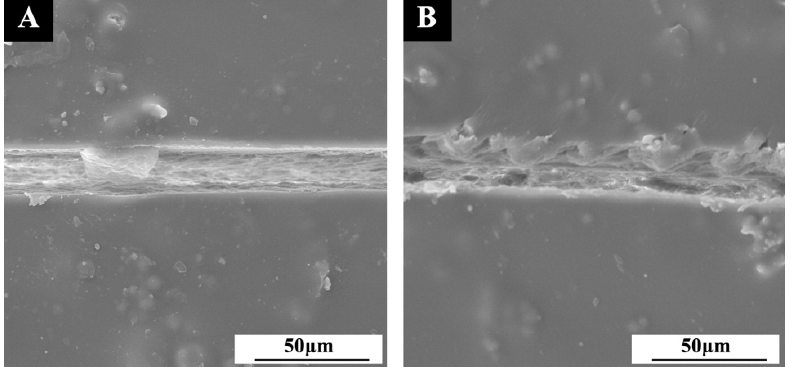
Figure 18. SEM of self-repairing coating with 3.0 wt.% transparent shellac microcapsules: ( A ) when cracks occurred; ( B ) after 5 d.